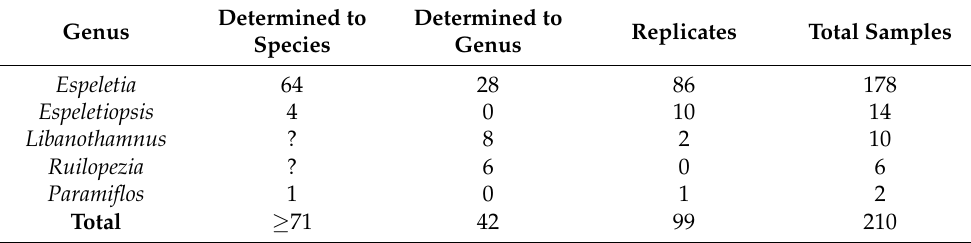
Determined to Genus